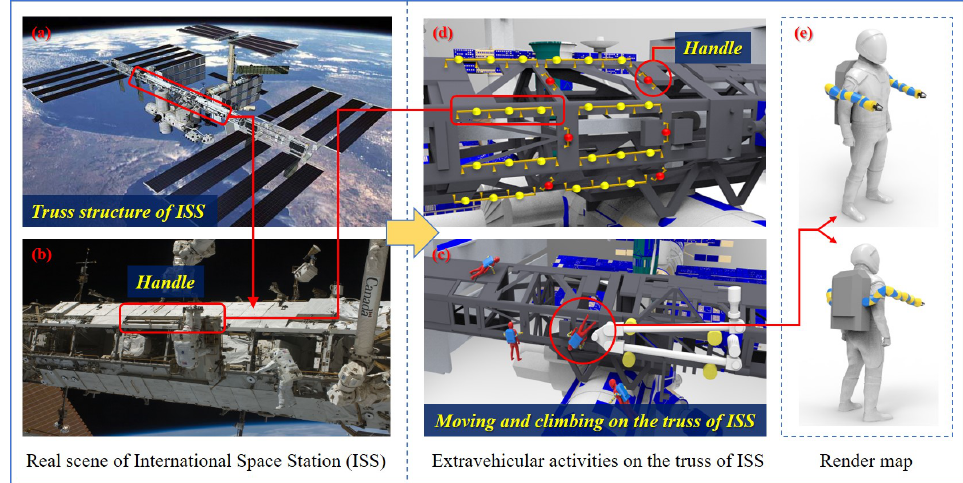
Figure 1. Simplified environment of ISS, and the render map of the AstroLimbs. ( a , b ) Real scene of ISS. ( c , d ) Extravehicular activities on the truss of ISS. ( e ) Render map of the